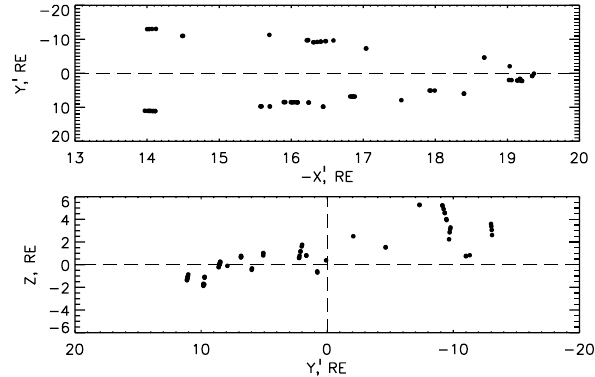
Fig. 3. Neutral sheet position ( B x = min ( | B x | ) at the Cluster barycenter) projections onto X 0 − Y 0 and Y 0 − Z planes for the 78 se- lected cases ( X 0 , Y 0 - aberrated GSM coordinates, see explanation in the